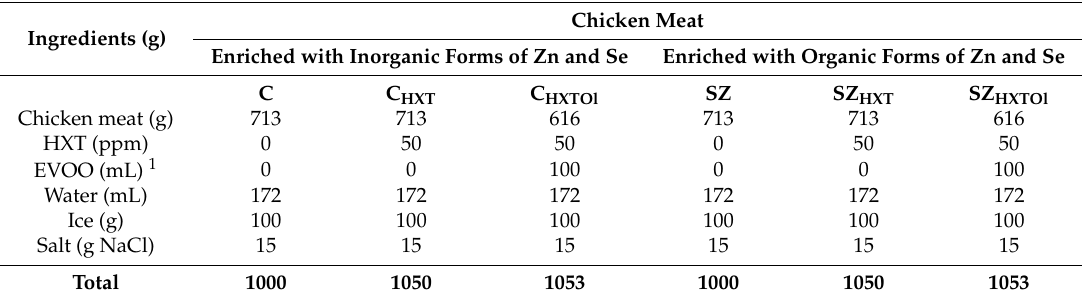
Table 2. Ingredients (g) of chicken emulsion